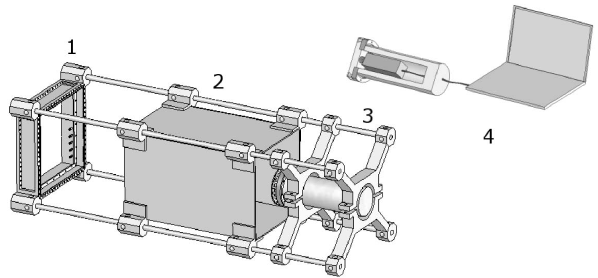
Fig. 1. Schematic illustration of the Bubblemeter: A homoge- neous high intensity light source combined with a power pack (De- vice 1) illuminates the field of observation. A box (Device 2) filled with clear water reduces water turbidity within the optical path. A high speed camera inside a pressure housing (Device 3) records se- quences of bubble images which rise in the sample area between Device (1) and (2). Data sequences are transferred to a laptop PC (4) for further